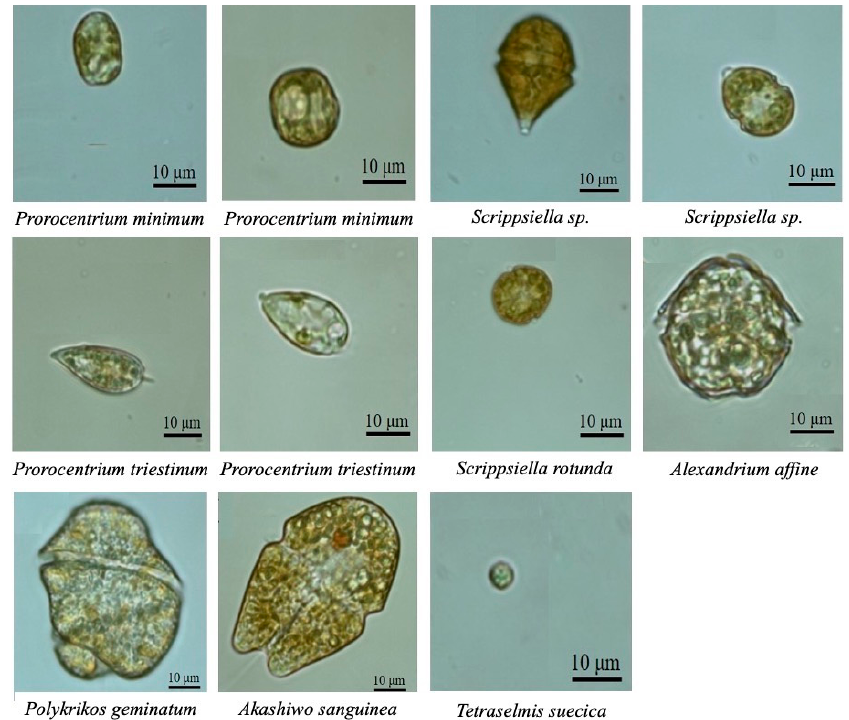
Figure 2. Morphology of algal strains used in this study under a light microscope (1000x). Table 2. Sequence analysis of dinoflagellate strains of the same species.